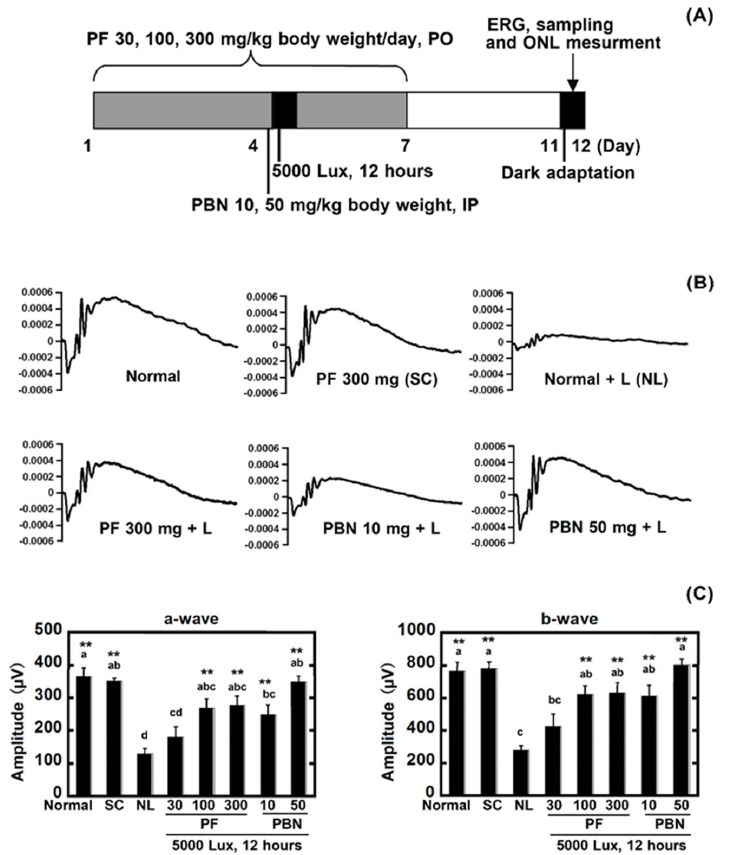
Figure 2. Protective effect of polyphenolic compounds fraction (PF) against light-induced retinal functional damage. ( A ) Experimental design. Rats were given oral PF (30 mg/kg, 100 mg/kg, and 300